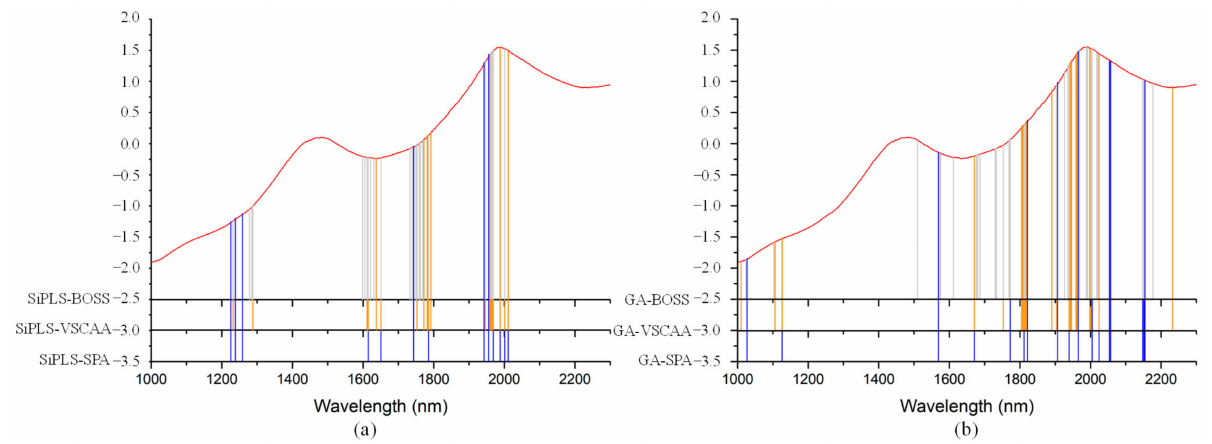
Figure 14. The useful variables selected by the ( a ) SiPLS and ( b ) GA algorithm for measuring TI.